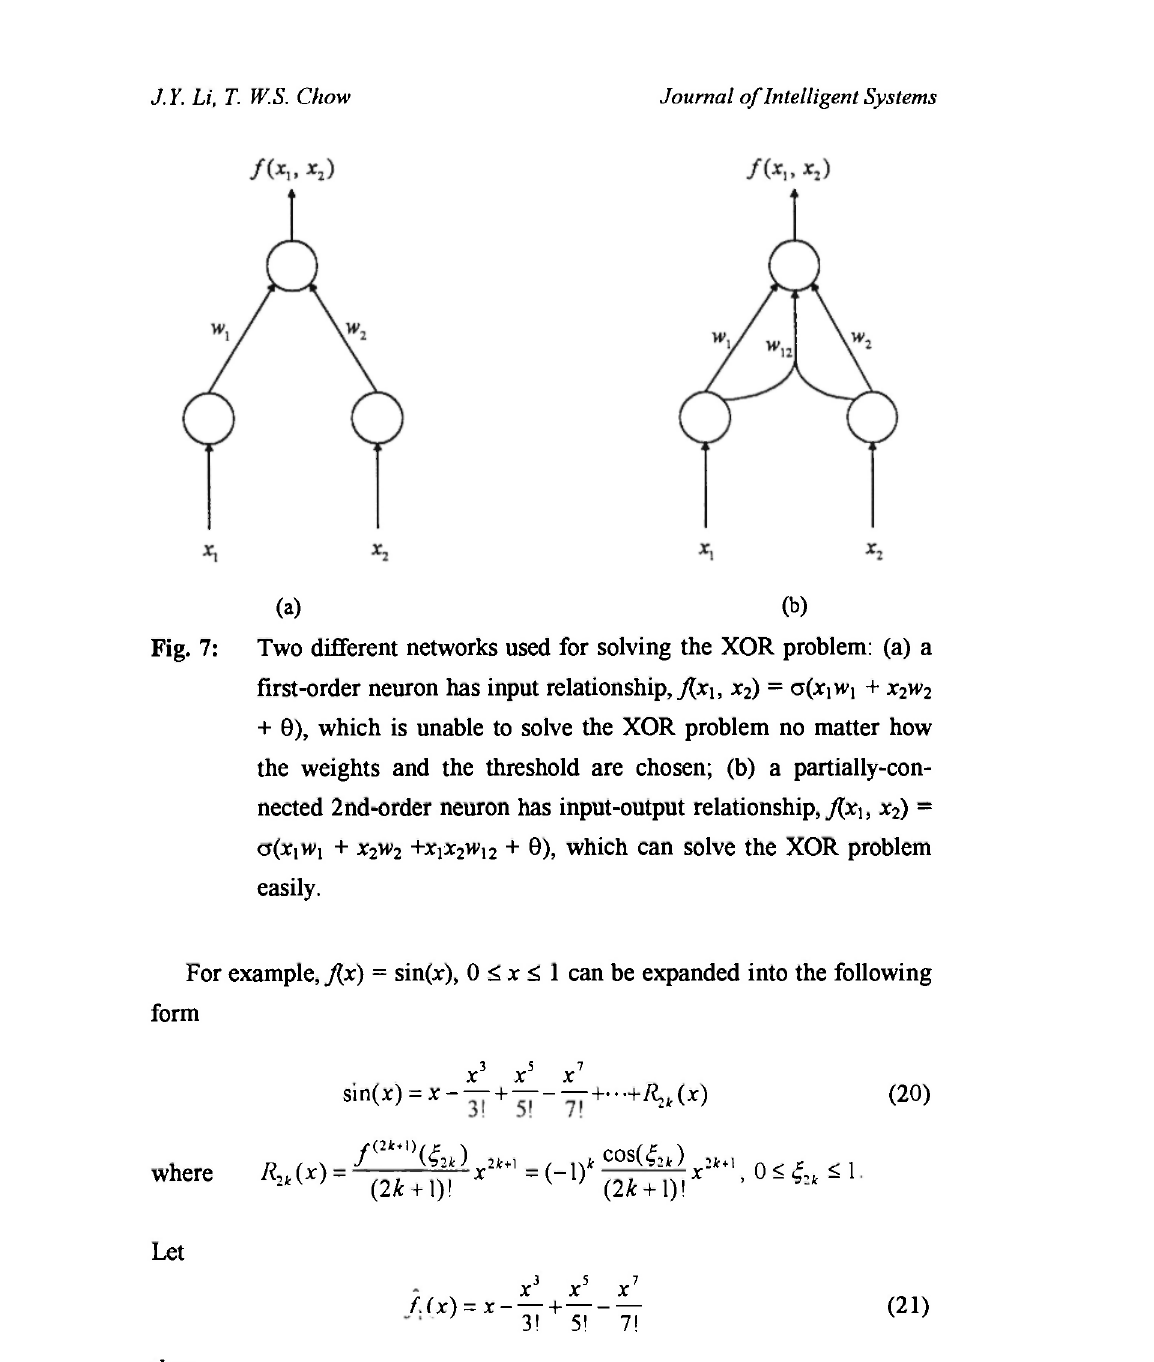
x ) = σ^π^ + x w u 2 2 2 ) = 2